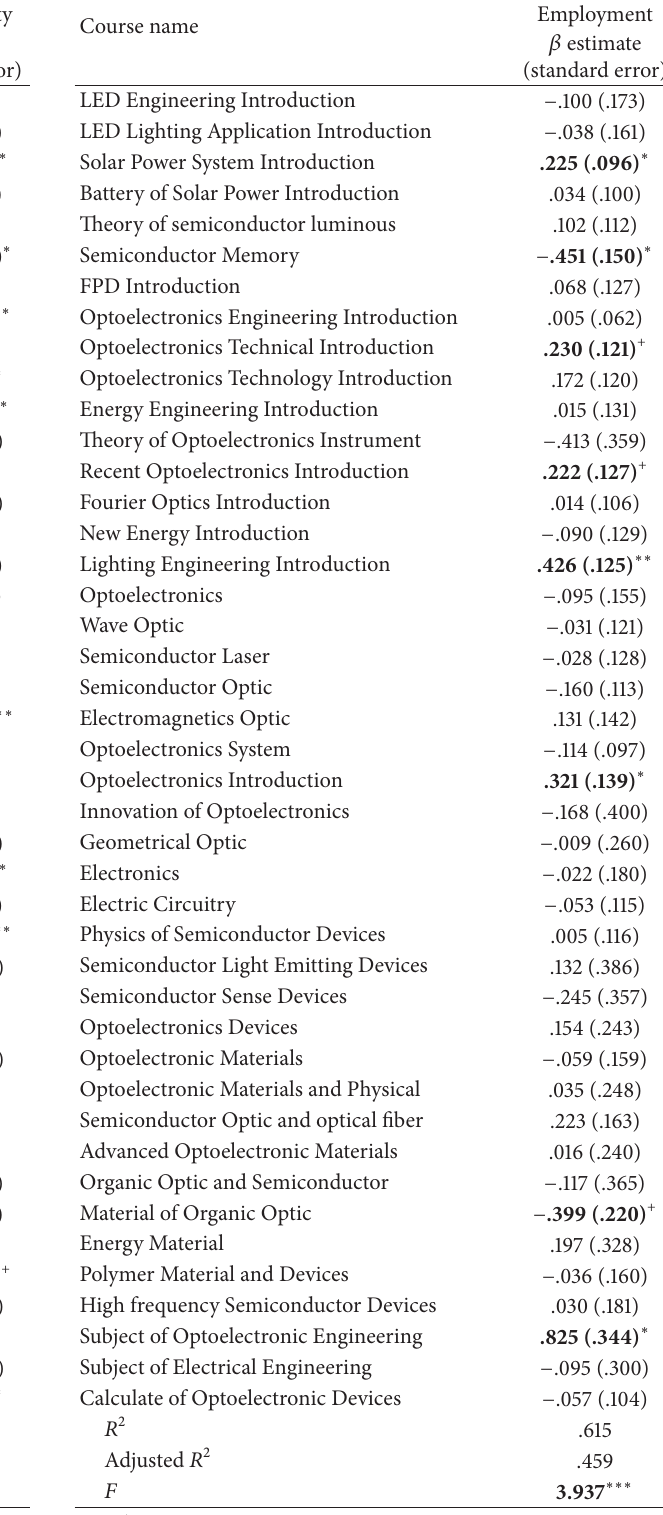
Table 11: Multiple regression analysis—cognitive domain curricu- lum on employability (industry